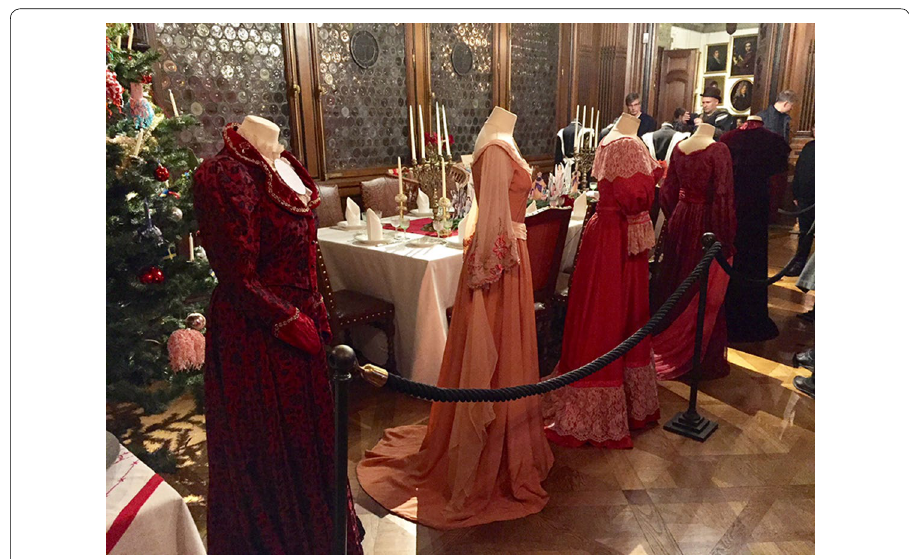
Fig. 1 Costumes by Marik Vos for Ingmar Bergman’s film Fanny and Alexander from 1983 on display in “Bergman à la mode”. This exhibition was curated by Anna Bergman and Nils Harning and held at the Hallwyl Museum in Stockholm in 2018, emphasizing the handicraft and the individual designers behind them. Photograph by the